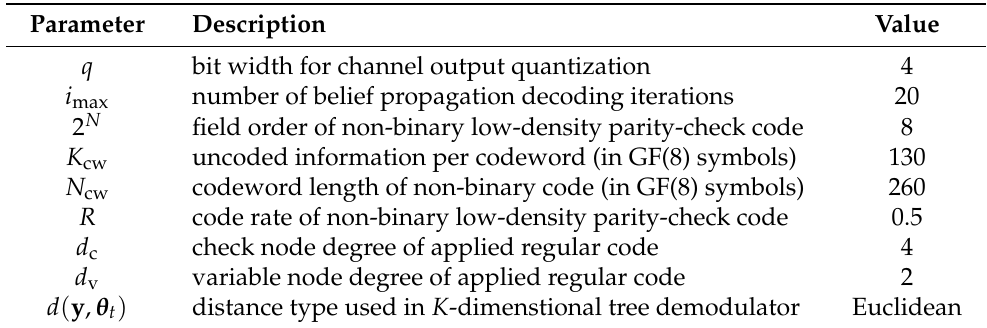
Table 2. Overview of parameters of data transmission